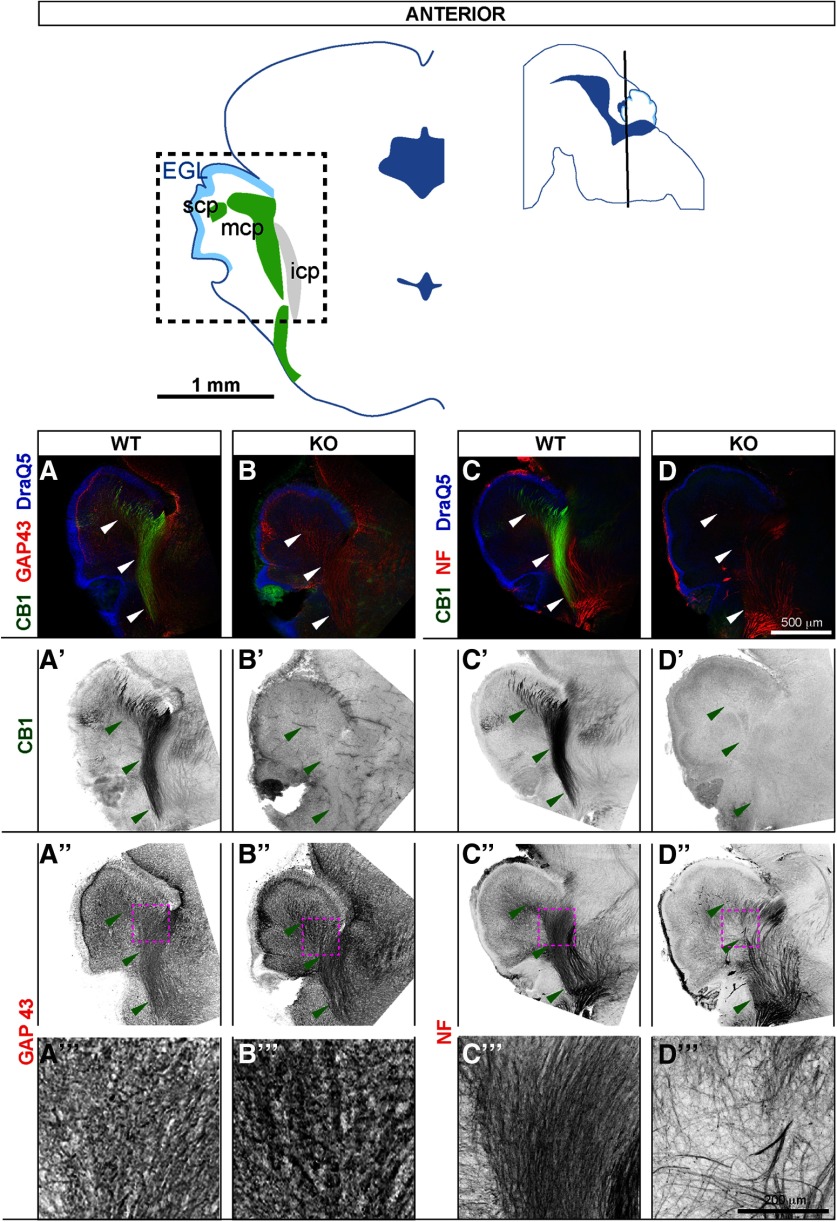
At E17.5, CB1 is highly expressed in cerebellar peduncles and is required for orderly arrangement of axons within the peduncles. Coronal sections at E17.5 through anterior cerebellar zone, scp and mcp are clearly seen in this plane of sectioning. Top row, left: outlines of a representative coronal section showing anatomic landmarks. Dotted square indicates the regions shown in panels A–D’’’. Top row, right: black line through sagittal diagram shows plane of sectioning. Anatomical locations are adapted from Paxinos et al. (2007). A–A’’’, In WTs, CB1 co-localizes with GAP43, a marker of elongating axons, and with axonal neurofilaments (C–C”). Large fascicles of CB1-positive axons run through scp and mcp (highlighted by arrowheads). B–B’’’, D–D’’’, CB1 staining is absent in KO littermates. Furthermore, density of GAP43 staining within the peduncles is increased in CB1 KOs (A”, A’’’ vs B”, B’’’), and distribution of axons as judged by neurofilament staining appears abnormal (C”, C’’’ vs D”, D’’’). Panels in the bottom row (A’’’, B’’’, C’’’, D’’’) show zoomed-in views from regions indicated by maroon dotted outlines in (A”, B”, C”, D”).